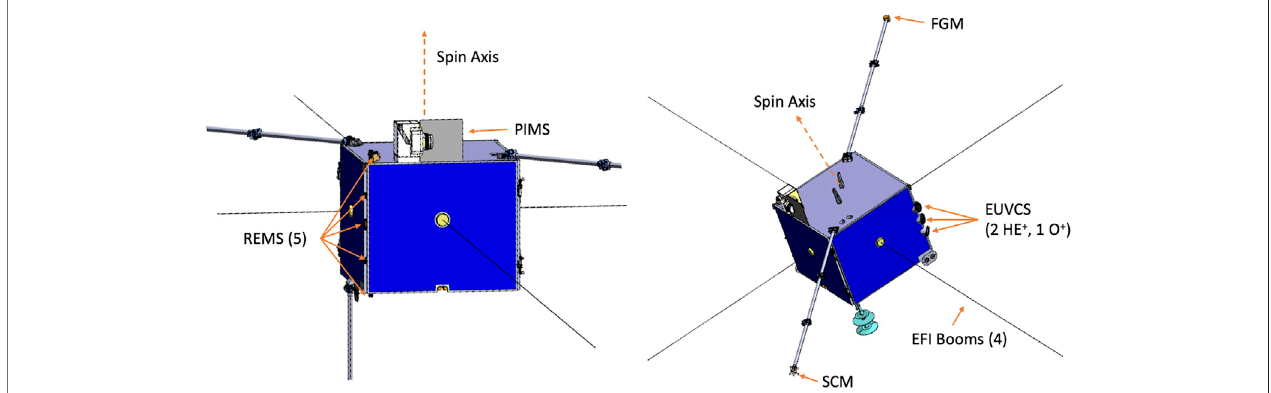
FIGURE 5 | PlasmaSatEUV spacecraft, with instruments indicated. The EFI booms are shown truncated. Their nominal base-to-tip length is 50 m each.